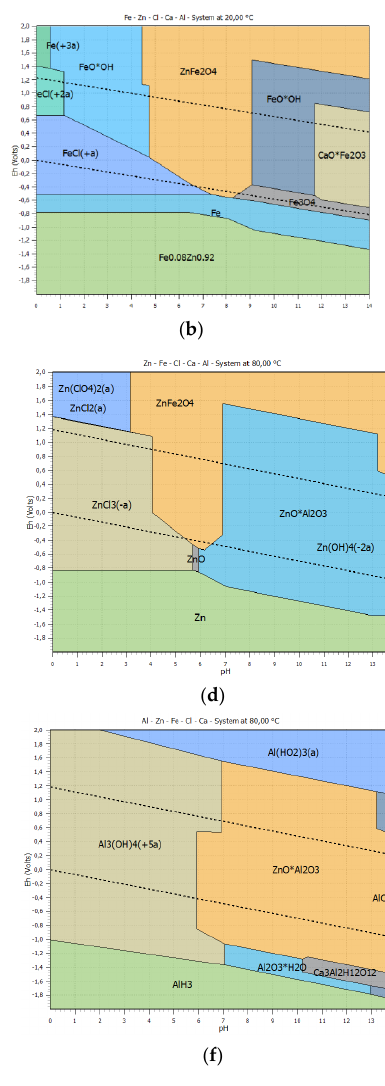
Figure 4. Eh-pH diagram for Zn-Fe-Cl-Ca-Al-H 2 O system: ( a ) Zn 20 °C; ( b ) Fe 20 °C; ( c ) Al 20 °C; ( d ) Zn 80 °C; ( e ) Fe 80 °C and ( f ) Al 80 °C. Molarity: (Zn) = 1.85 M, (Fe) = 0.0475 M, (Cl) = 2.00 M and (Ca) = 0.017, (Al) = 0.0877 M.